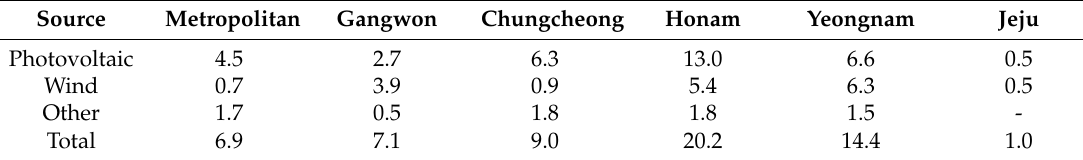
Table 1. Predicted renewable energy generation capacity of 2030 by region